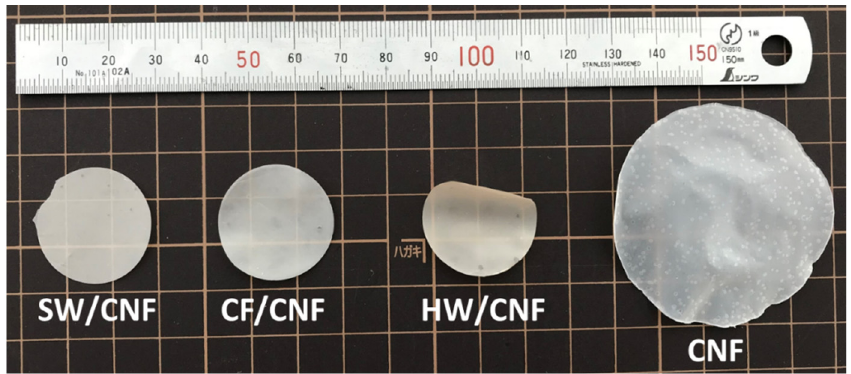
Figure 2. Photograph of the membranes. The lignin-containing samples were more rigid and better attached to the polystyrene dishes used for casting. Only circles 2.5 cm in diameter were recovered, while CNF was completely self-detached from the substrate after drying.